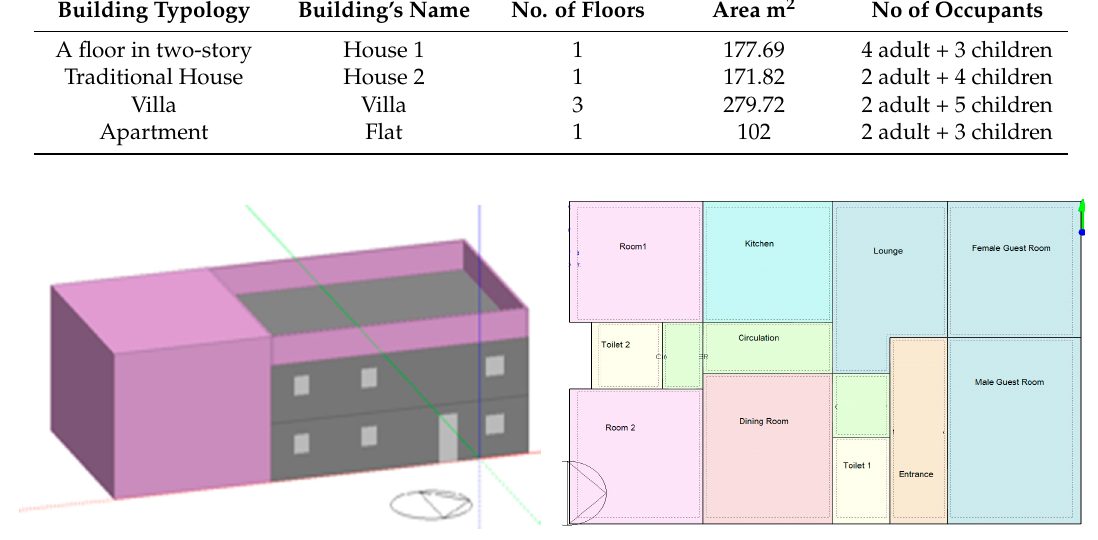
Figure 5. The plan and geometric description of House 1.